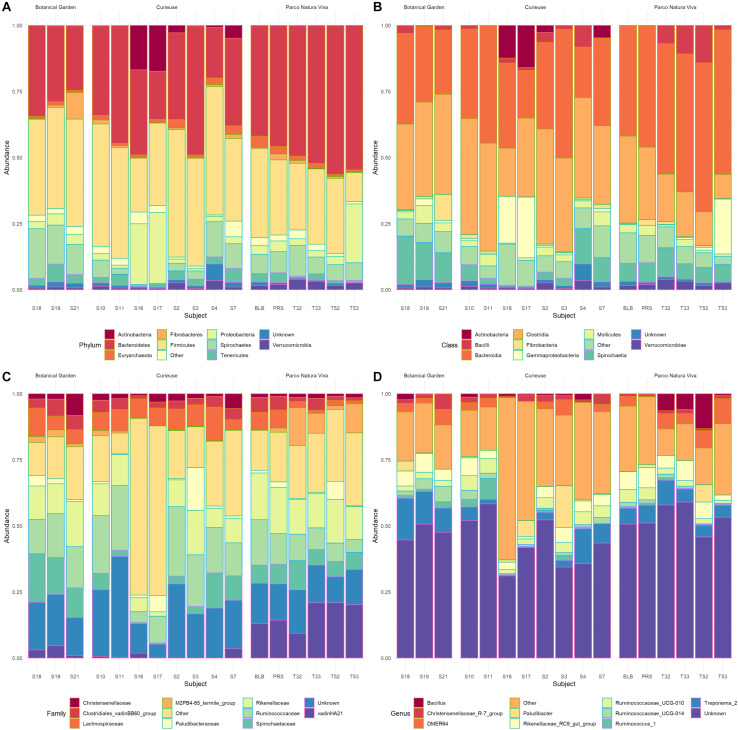
Bar plots representing the percentage abundance of the top 10 Phyla (A), top 10 Classes (B), top 10 Families (C), and top 10 Genera (D). The samples are grouped based on location.